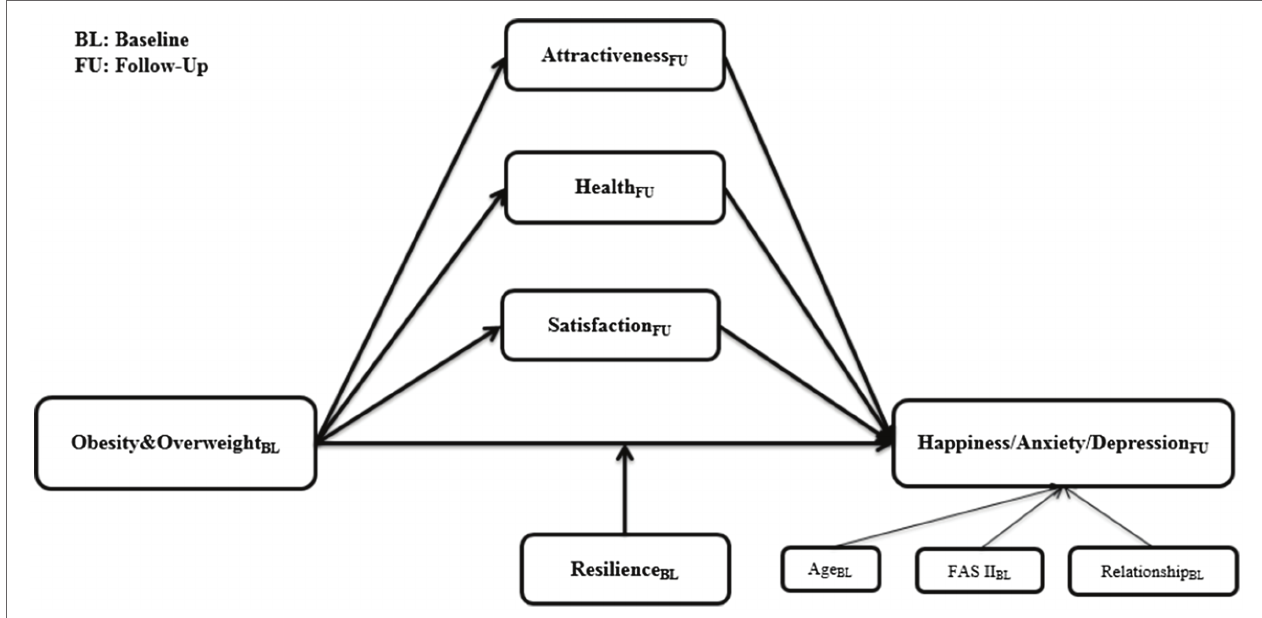
FIGURE 1 | Model with attractiveness, health state, and satisfaction from follow-up as mediators and resilience from baseline as moderator.